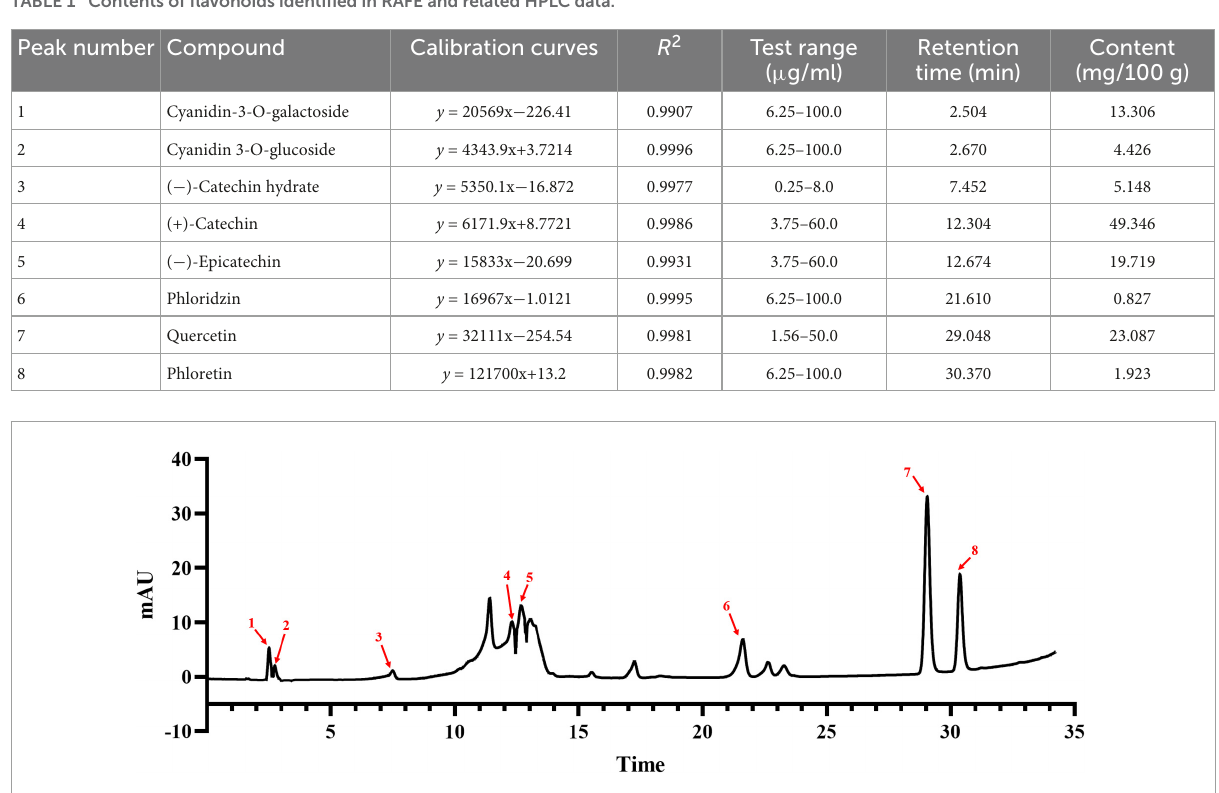
FIGURE2 Composition and content of flavonoids in RAFE based on HPLC analysis. HPLC plot of RAFE, where the eight peaks labeled in the plot correspond to the flavonoid compounds with the same serial numbers as those in Table 1